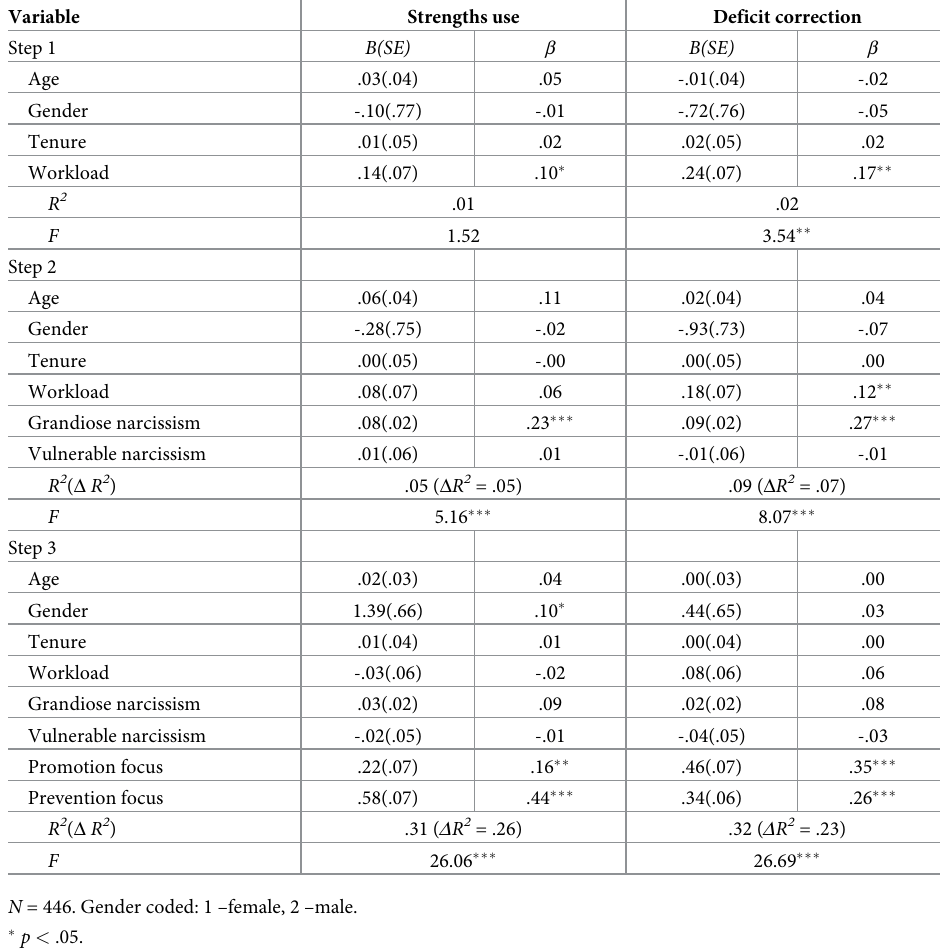
Table 2. The results of hierarchical regression